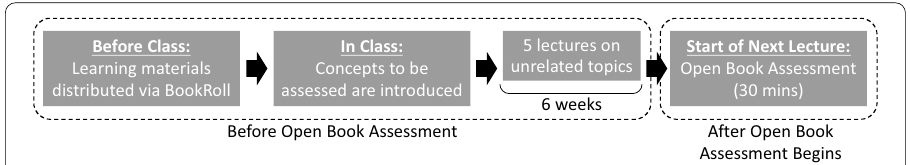
Fig. 2 Timeline overview of the class and open-book